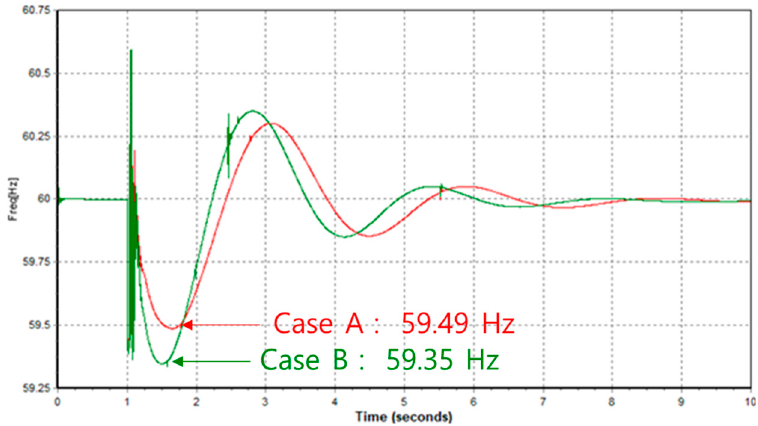
Figure 5. Simulation results of Cases A and B; effect of the number of RMR units.